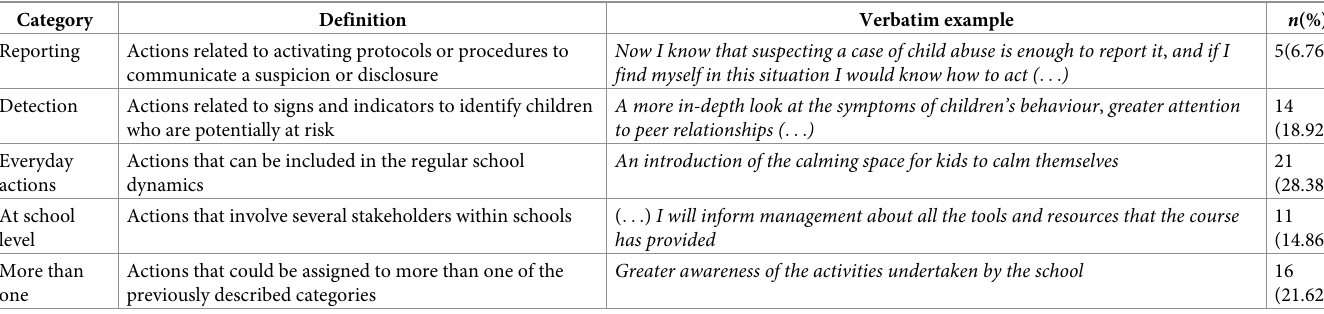
Table 4. Categorizing system for the actions described by school staff.